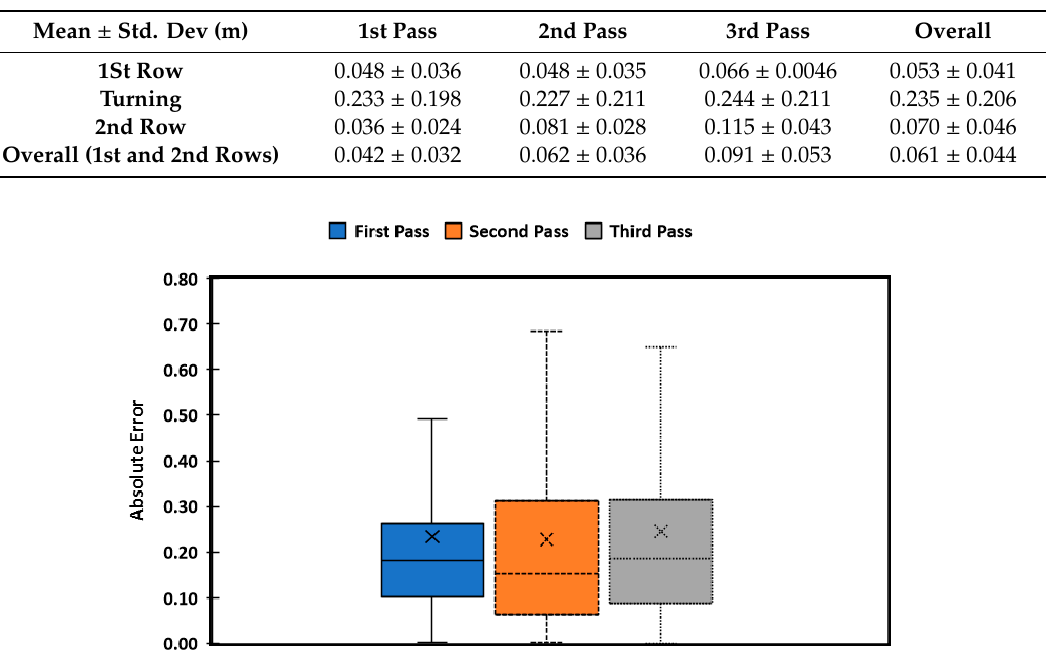
Figure 17. The average of absolute errors (A.E.) when turning for the first, second, and third passes (blue, orange, and gray boxes, respectively). The rover had no significant difference in turning performance. The boxes present the first quartile to the third quartile of A.E., while the whiskers show maximum values and minimum values of each of the passes. The “x” shows the mean absolute error (MAE) for each of the passes.